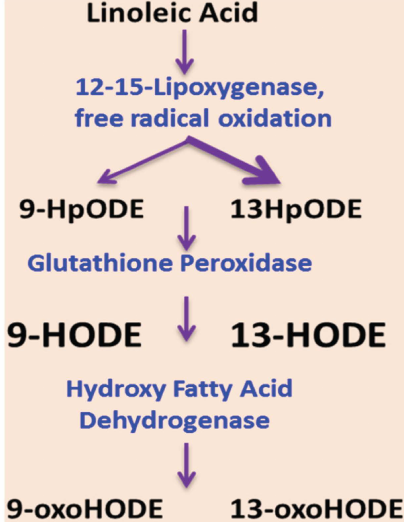
Figure 2. Oxidative metabolism of linoleic acid. LA can be enzymatically or non-enzymatically converted to 9- and 13-HpODE, with subsequent enzymatic conversion to hydroxy (9- and 13-HODE) and ketone (9- and 13-oxoODE) derivatives. Abbreviations: HpODE: hydroperoxy-octadecadienoic acid; HODE: hydroxy-octadecadienoic acid; oxoODE: oxo-octadecadienoic